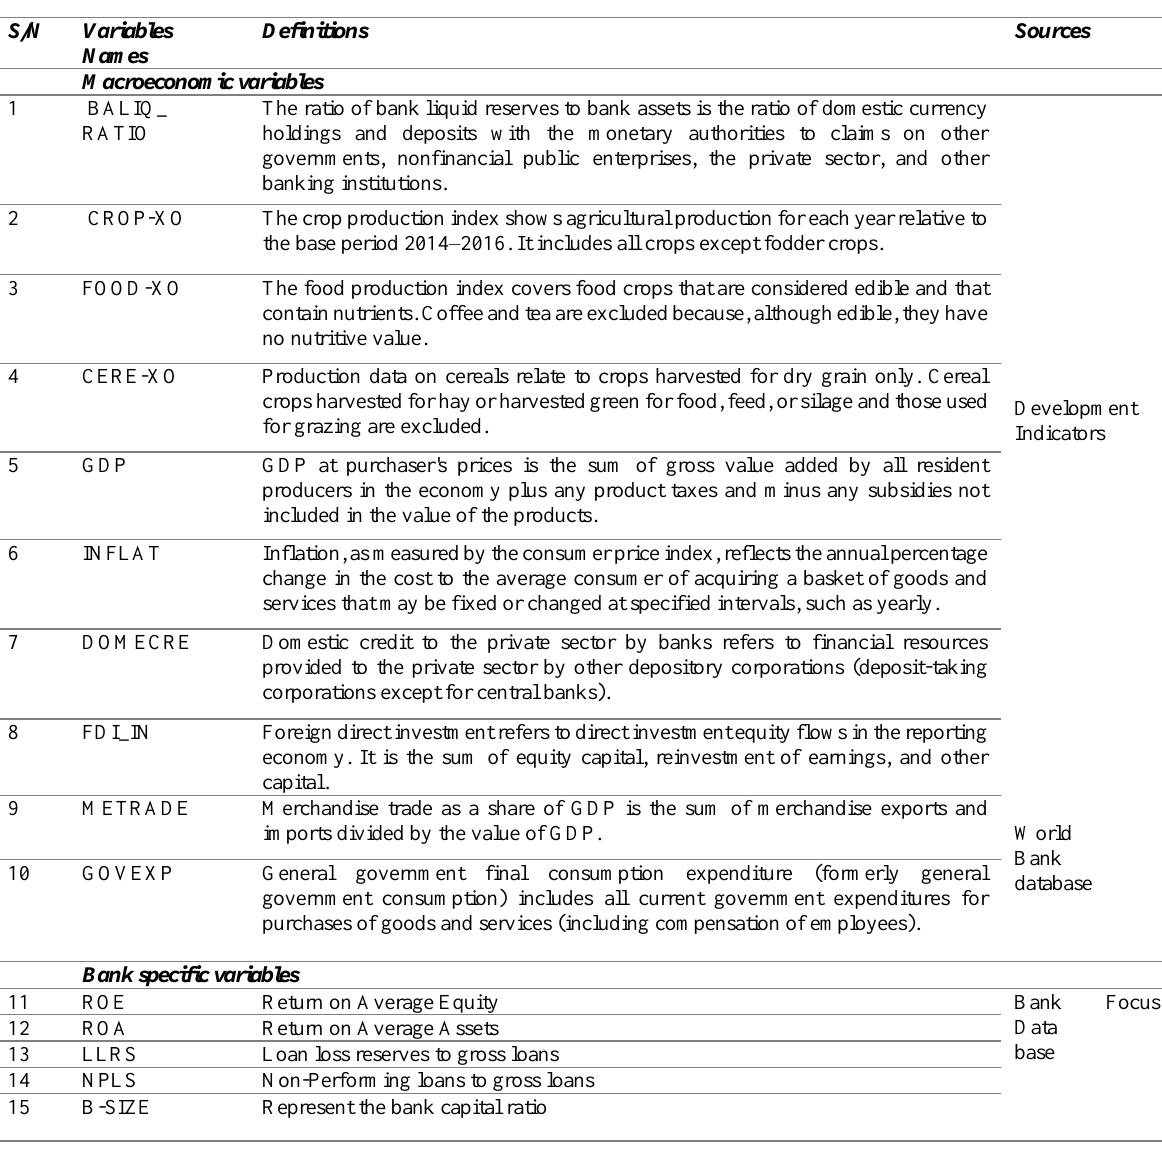
Table 1: Variable Definitions and